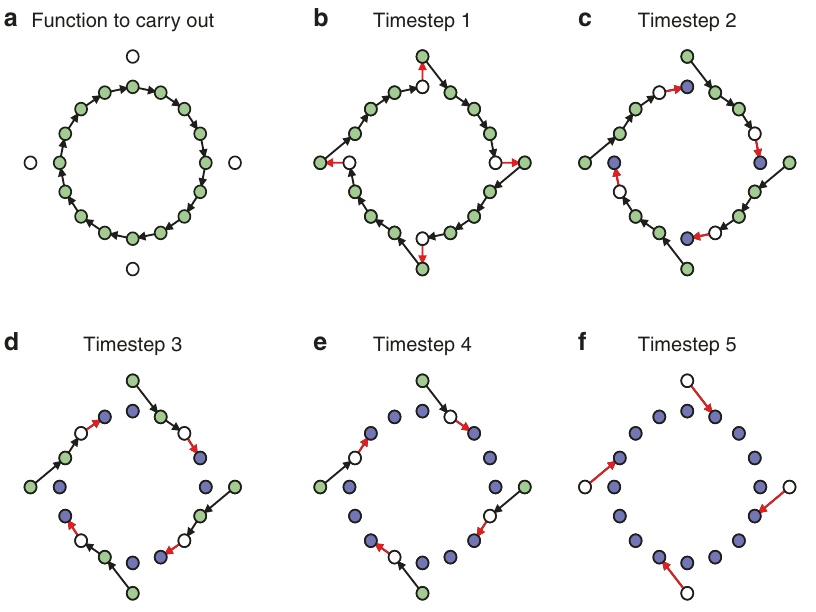
Fig. 2 Minimal-timestep implementation of a cyclic permutation with 4 hidden states. The implementation carries out the function f : x 7! x þ 1 mod16 over 16 states (green circles in ( a ), using 4 hidden states (white circles in a ). In all subplots, white nodes indicate states that cannot have any probability, light green nodes with outgoing black arrows indicate states that may have positive probability but are not yet mapped to their fi nal output, and purple nodes indicate states that may have positive probability and have been mapped to their fi nal outputs. Subplots b – f show the state of the system after each of the 5 timesteps required to carry out f , where red arrows indicate the idempotent function carried out in each timestep (in each timestep, any state without outgoing red arrows is mapped to